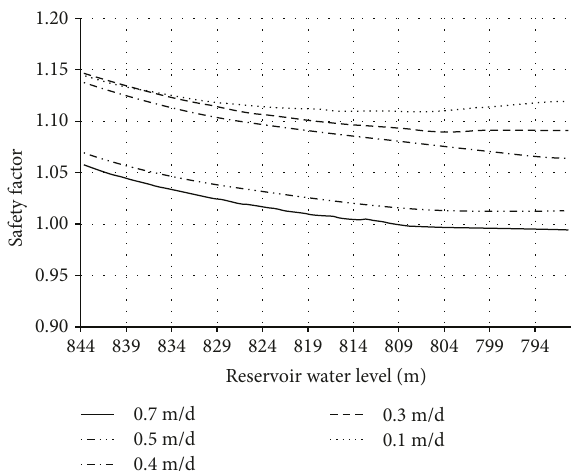
Figure 20: The variations of slope safety factor under di ff erent reservoir water level declination